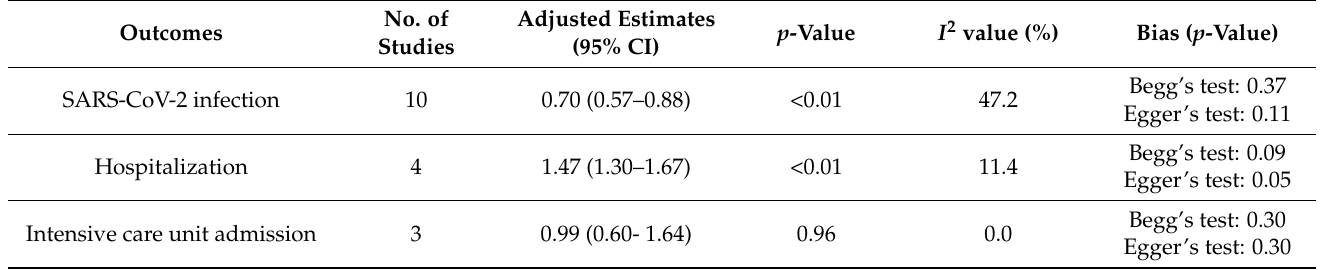
Figure 4. Forest plot for the association between pneumococcal vaccination and SARS-CoV-2 infection. Table 7. Effect sizes, heterogeneity statistics and results for publication bias of the association between pneumococcal vaccination and SARS-CoV-2 infection and outcomes.